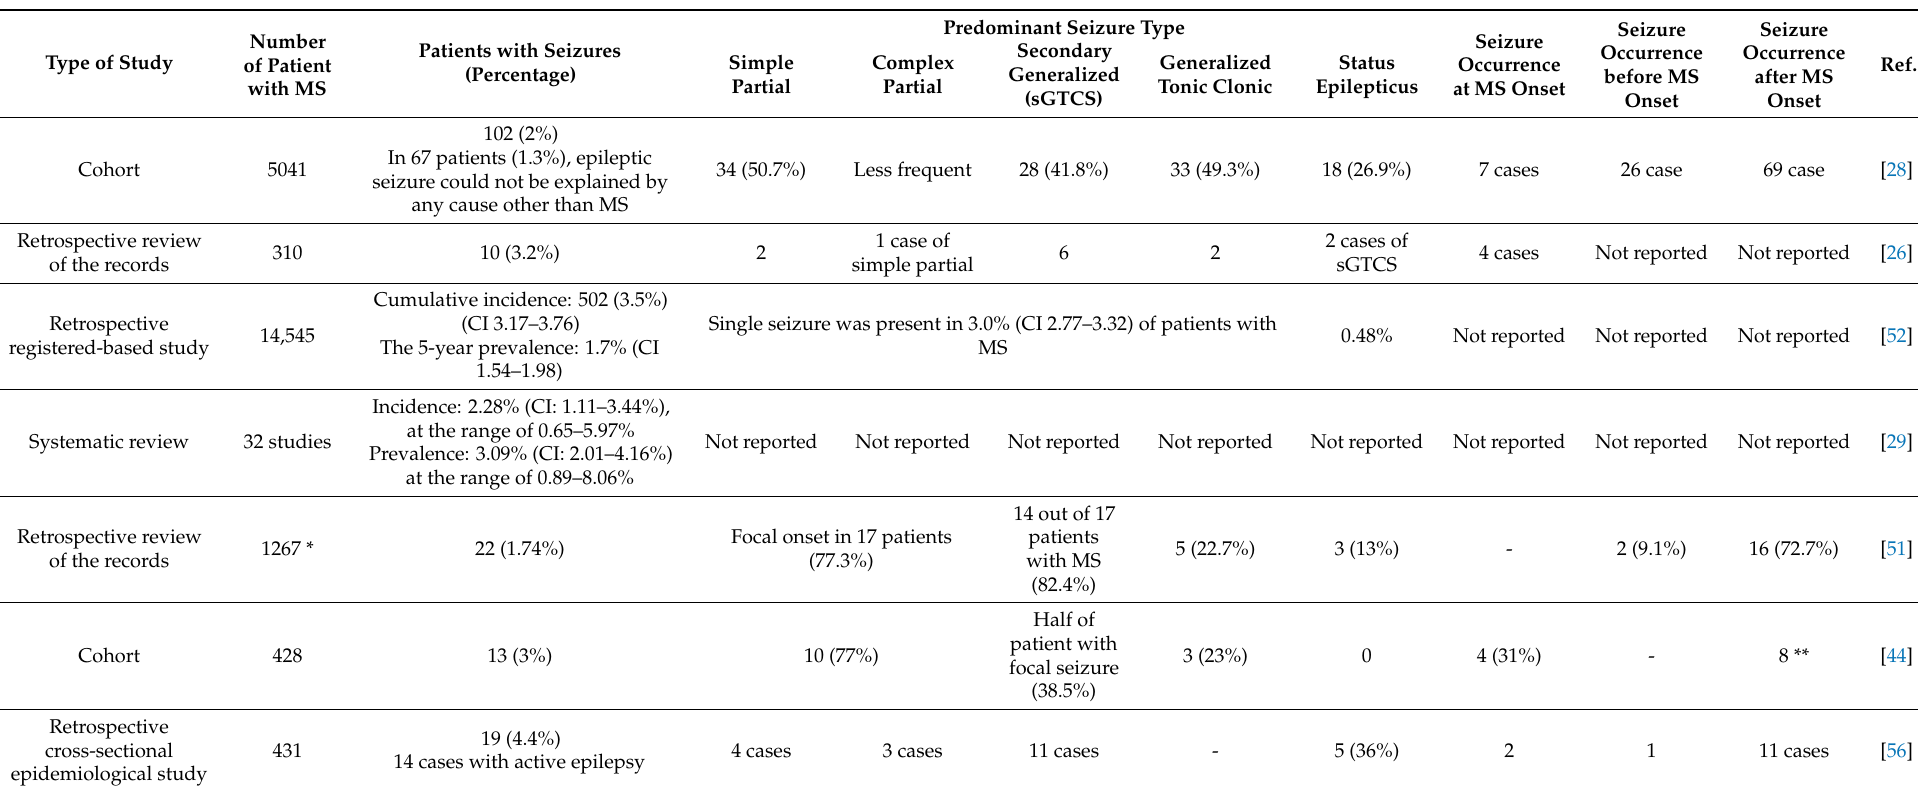
Table 2. Summary of published studies on epileptic seizures in patients with